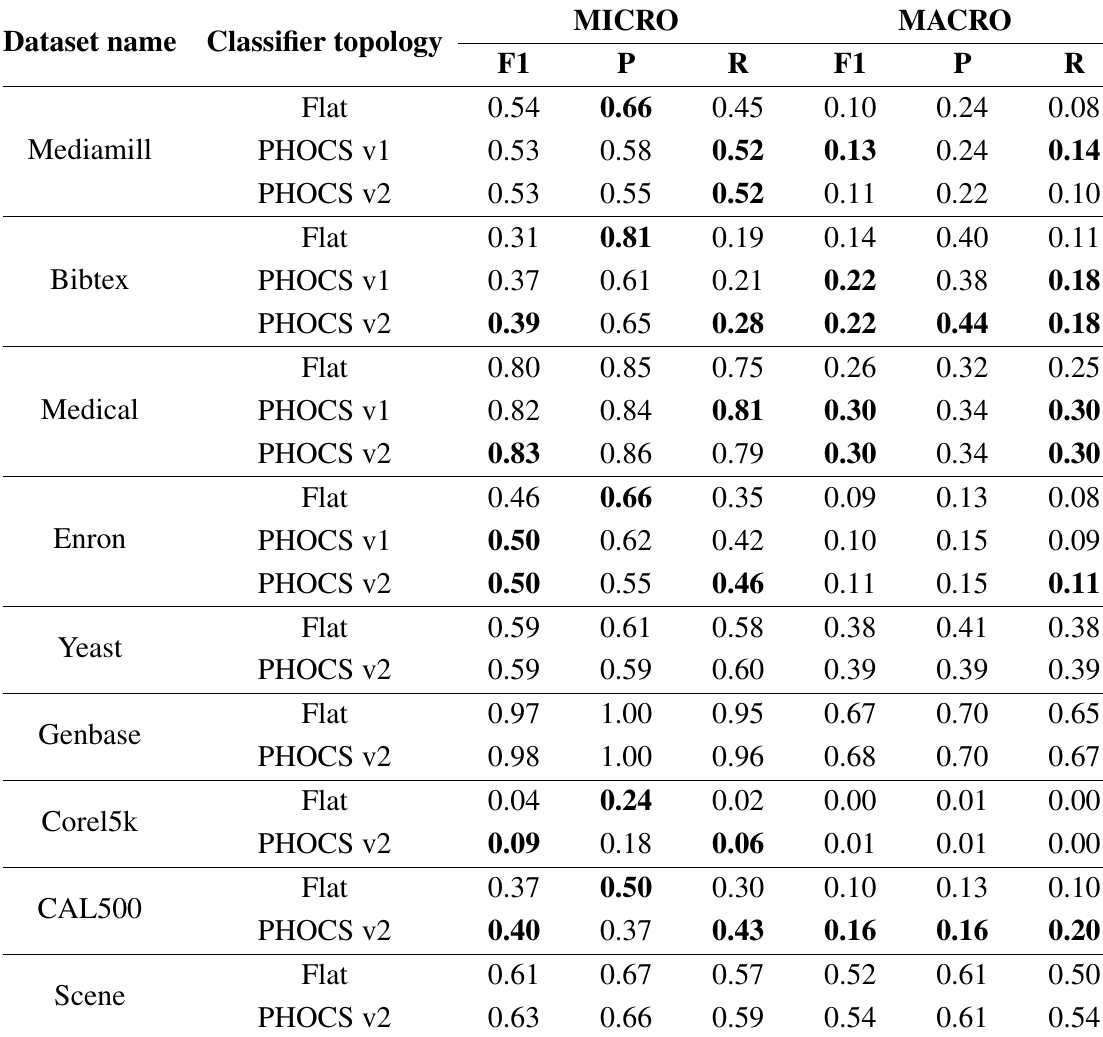
Table 2. PHOCS experiment